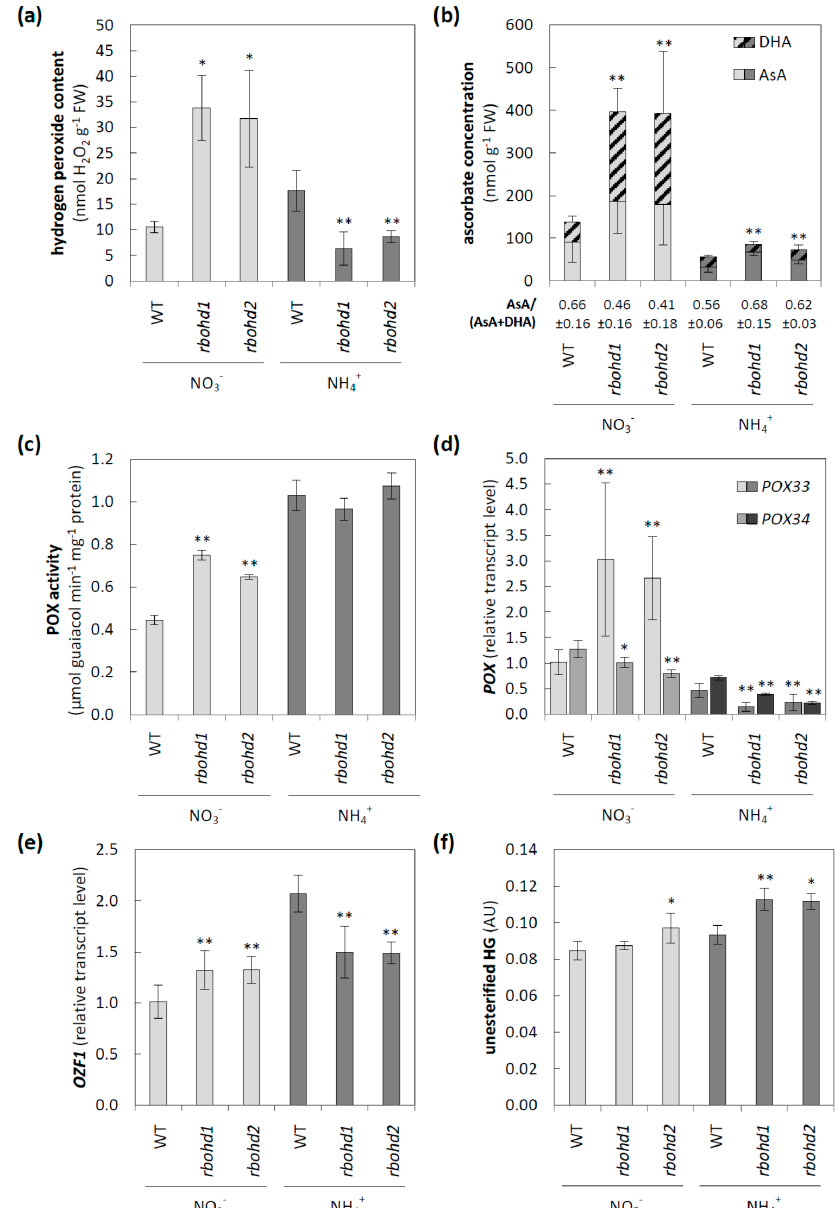
Figure 5. Changes in apoplastic metabolism of reactive oxygen species and the level of esterification of pectin resulting from RBOHD dysfunction in Arabidopsis grown in nitrate or ammonium as a sole nitrogen source. ( a ) The level of hydrogen peroxide in extracellular space. ( b ) The concentration of ascorbate and dehydroascorbate in leaf extracellular washing fluid. ( c ) Peroxidase activity in cell-wall-associated proteins. The transcript levels of ( d ) peroxidase 33 and peroxidase 34 and ( e ) oxidation-related zinc finger 1. ( f ) The level of unesterified pectin isolated from alcohol insoluble residue. Comparison tests between rbohd and WT plants were performed on the mean experimental conditions for the nitrate (light grey) or ammonium (dark grey) growth regime separately. Statistical differences calculated using one-way analysis of variance (ANOVA) with Tukey’s post hoc test are indicated at p -value ≤ 0.01 ** and p -value ≤ 0.05 *.